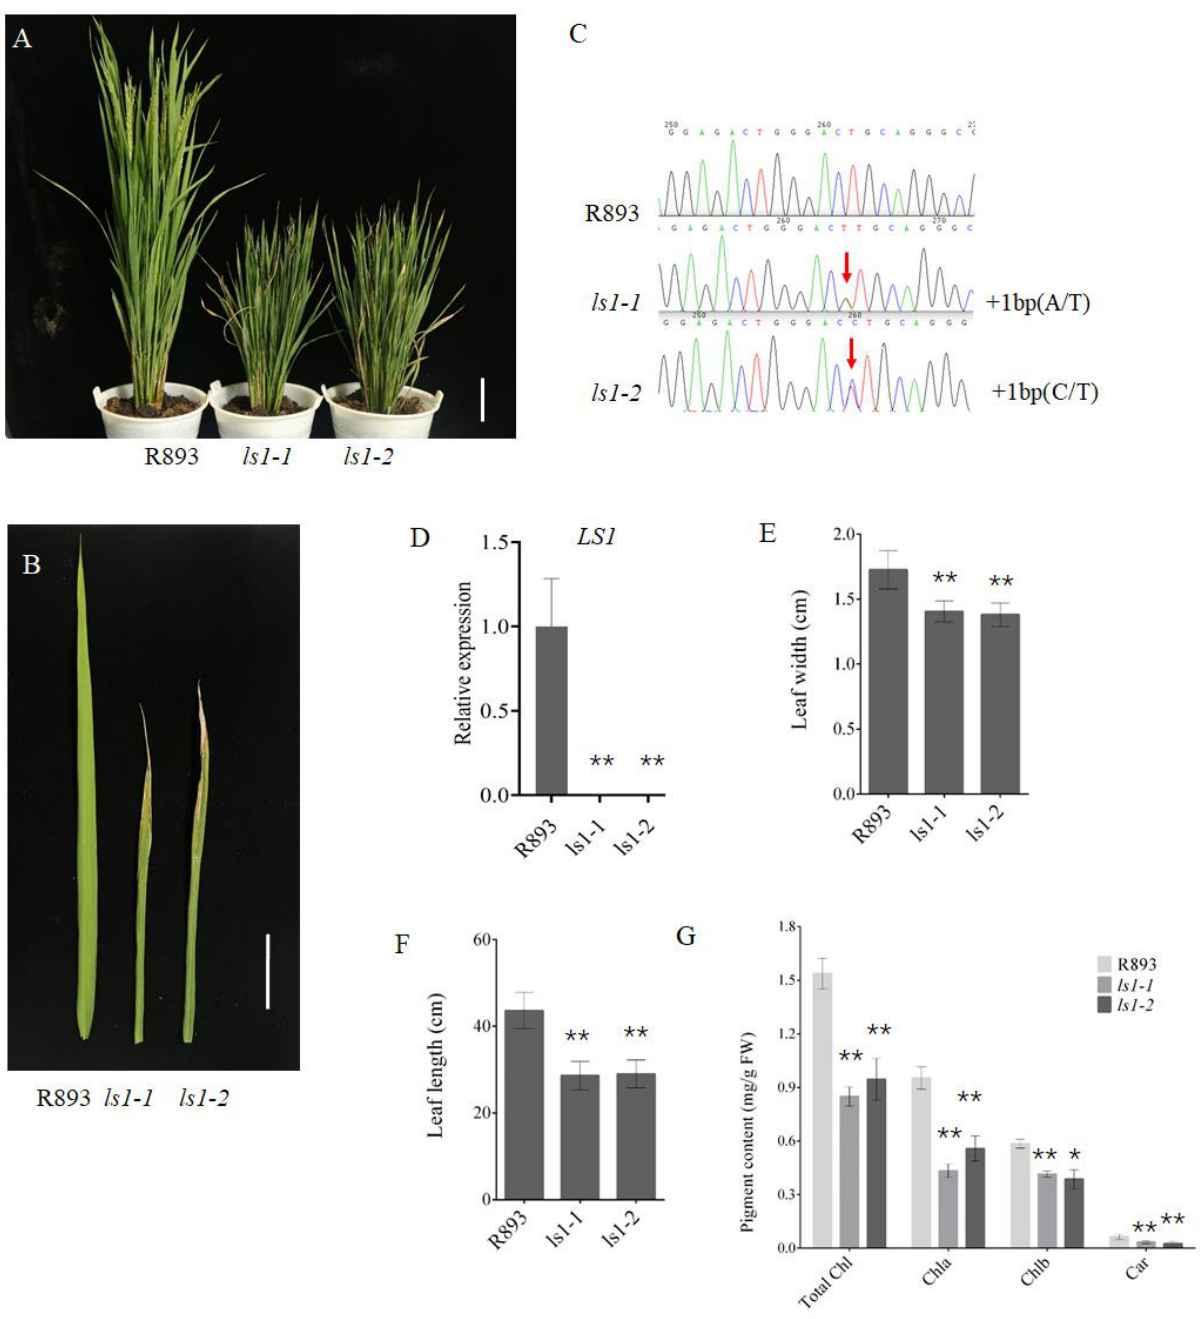
Figure 2. Phenotypic characterization of WT and ls1 plants. ( A ) Phenotypes of WT and ls1 mutants at the heading stage. ( B ) Leaf phenotype of WT and ls1 plants at the heading stage. ( C ) Mutation sites of LS1 gene in the ls1-1 and ls1-2 plants. The “+” indicates the insertion and the numbers indicate the number of bases. The red arrow indicates the insertion position of the coding region. ( D ) LS1 expression level in WT and ls1 plants. ( E , F ) Length and width of leaves from WT, ls1-1 , and ls1-2 plants. ( G ) Determination of photosynthetic pigment content. The error bars indicate SDs of three biological replicates. The p -value was calculated using a Student’s t -test. ** p < 0.01, * 0.01 < p < 0.05. Bar = 20 cm ( A ); bar = 10 cm ( B ).